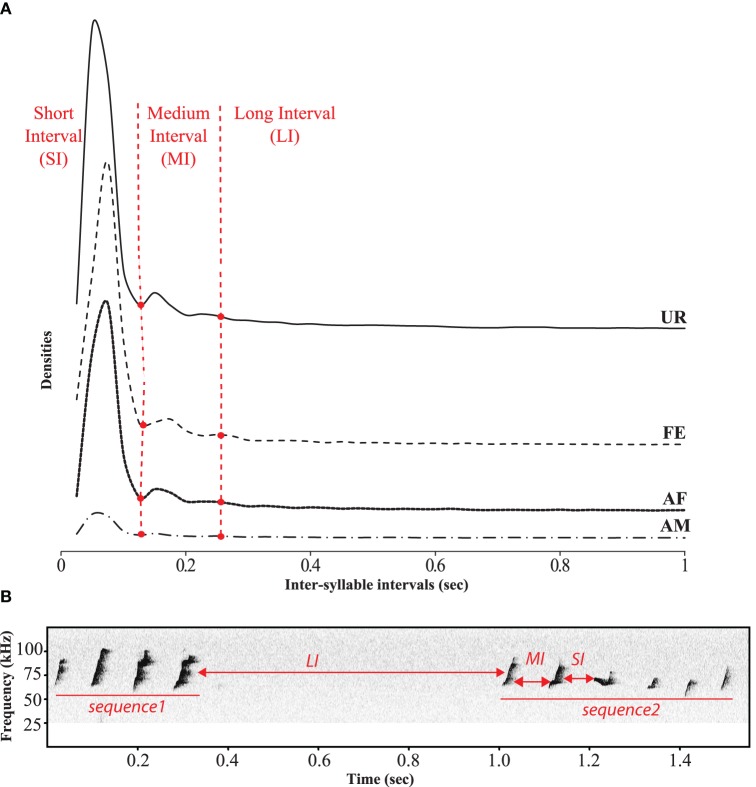
Temporal organization of sequences in different context. (A) Distribution of the inter-syllables intervals for the four conditions defining three types of silent intervals between sequences of syllables. (B) Representation of these three types of intervals on a sonogram separating two songs by a long interval.